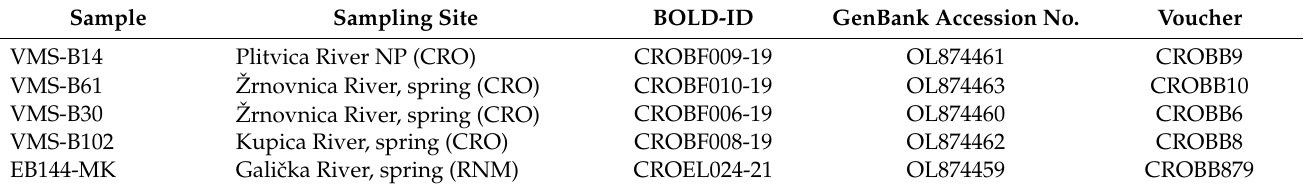
Table 2. Specimens of E. bosnica (Zaitzev, 1908) DNA, barcoded in this